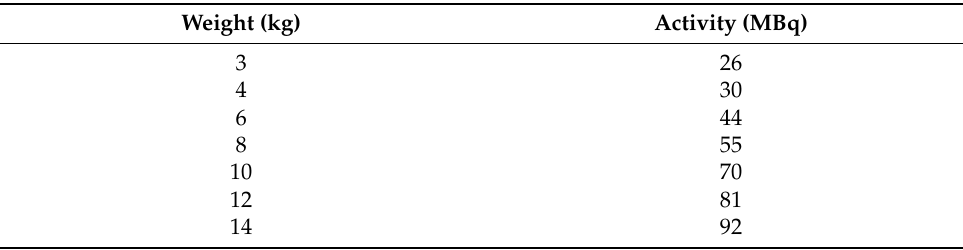
Table 2. Recommended 18 F-FDG activity, for men, for a positron emission tomography (PET) of the torso.